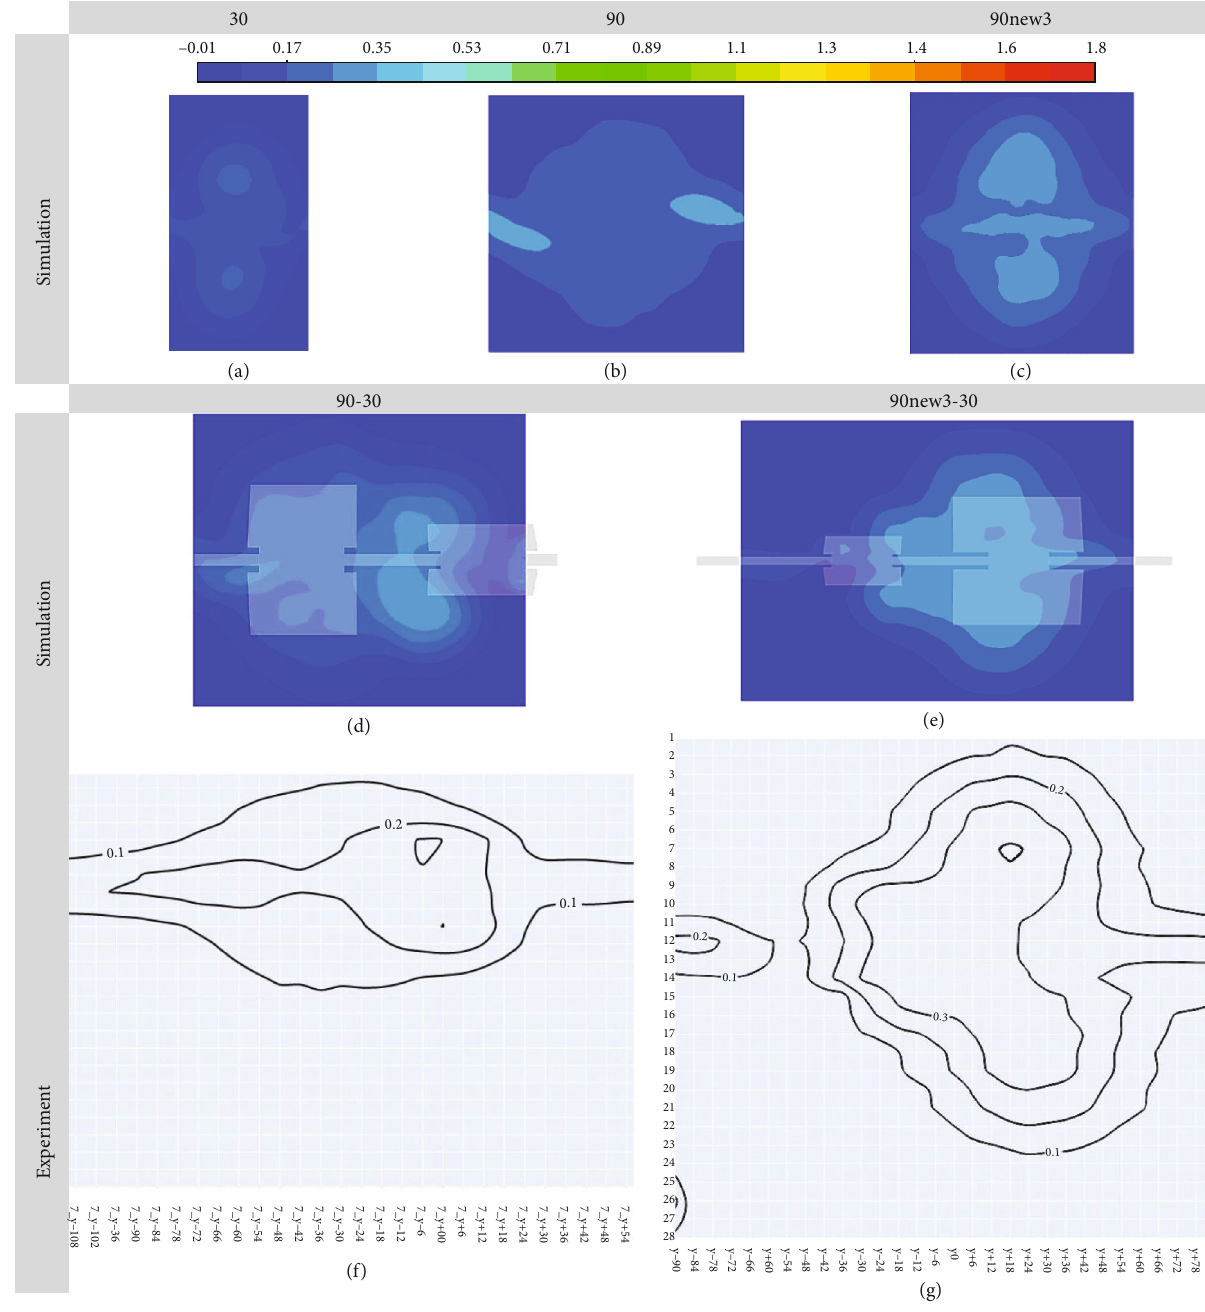
Figure 10: Comparison of the combined wake pattern at station 7 obtained from the present wind tunnel tests and numerical simulation for 90-30 and 90new3-30 arrangements besides the single